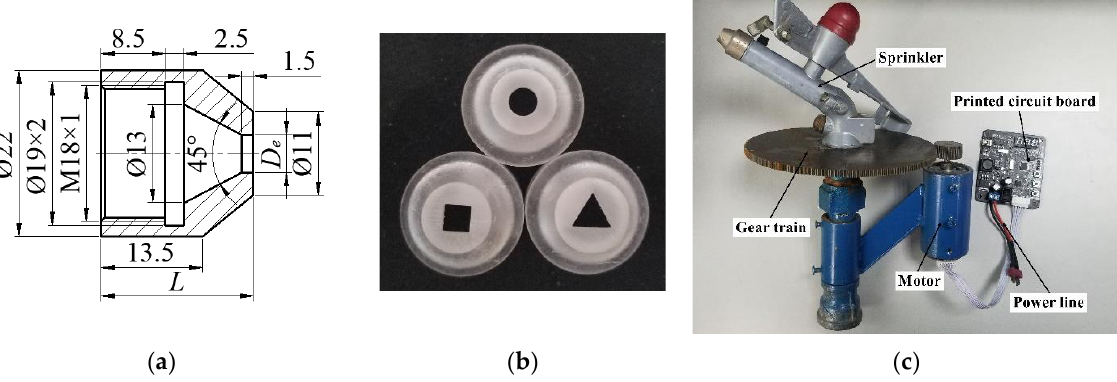
Figure 1. ( a ) The two-dimensional structure of the nozzles, ( b ) the noncircular nozzles, and ( c ) the self-designed rotating sprinkler device driven by a motor. Table 1. Nozzle dimensions and shape parameters of the nozzle orifice. Table 1. Nozzle dimensions and shape parameters of the nozzle orifice. Orifice